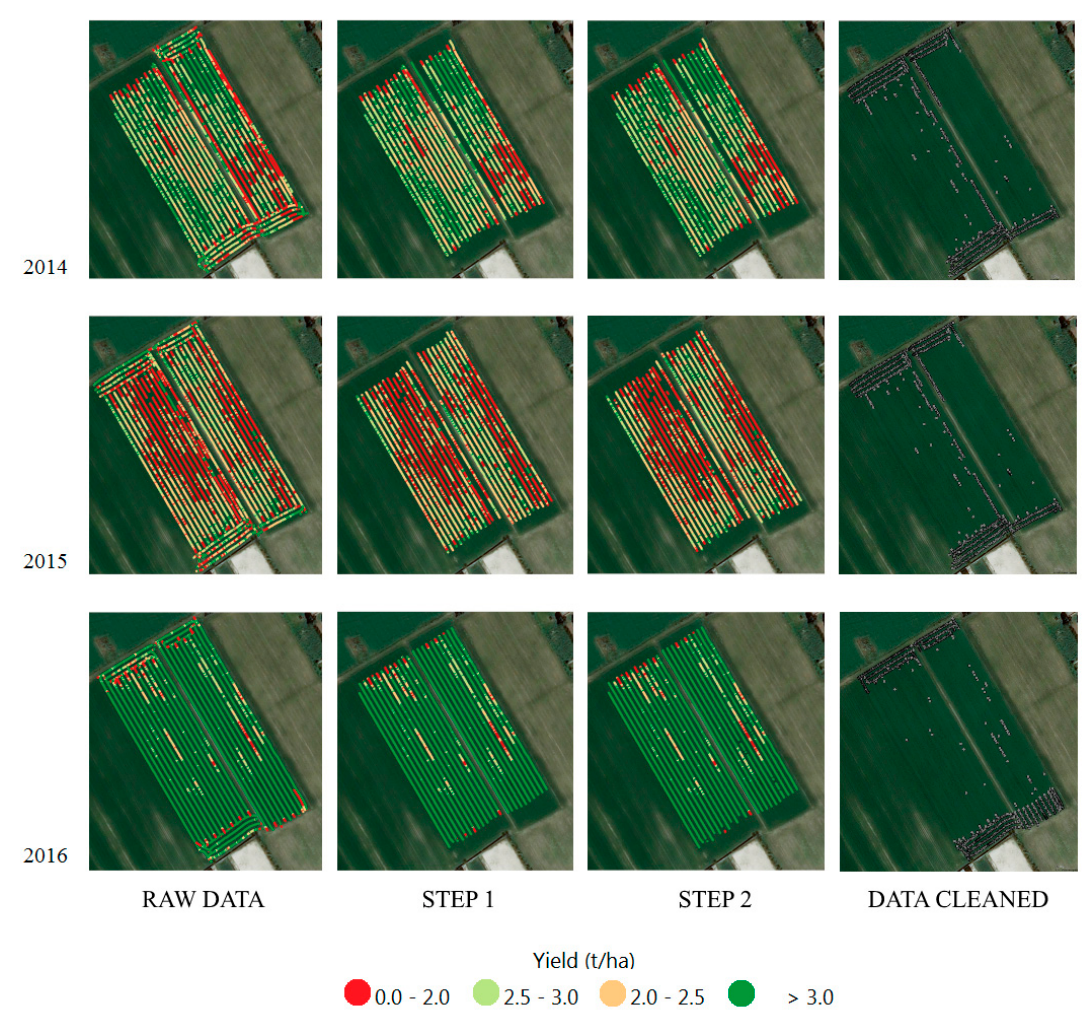
Figure 3. Maps showing yield monitoring datasets: Raw data (left), Step1 and Step2 data (center), data cleaned (right). Raw and Steps 1–2 maps are colored according to quartiles of yield distributions (data not interpolated).